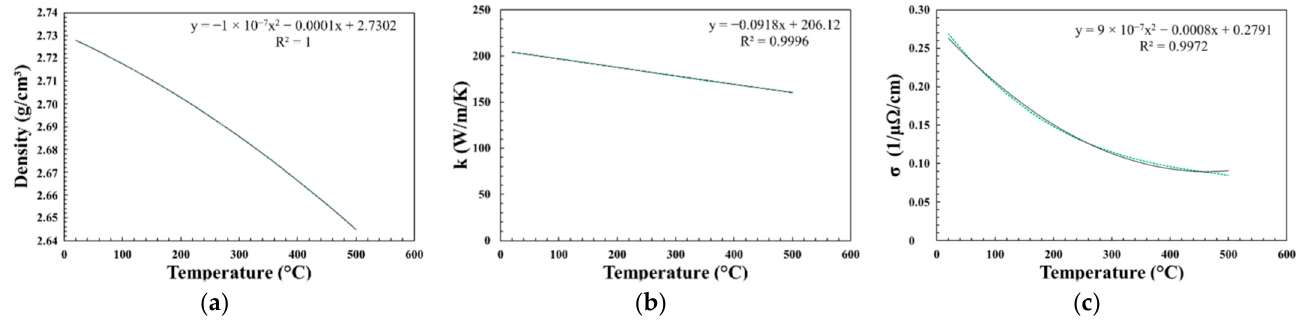
Figure A3. ( a ) Density, ( b ) thermal conductivity, ( c ) electrical conductivity of the AlSi7Cu3.5Mg0.15 (Mn, Zr, V) alloy as a function of temperature.